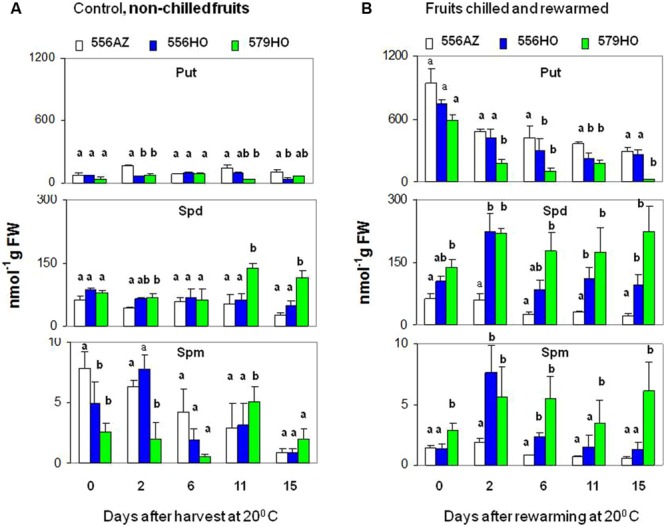
Changes in the levels of putrescine (Put), spermidine (Spd), and spermine (Spm) in (A) tomato fruits harvested at mature green stage (indicated by day 0) from the indicated lines and held at 20°C, representing controls for samples shown in (B) for which mature green fruits harvested from the indicated lines were first chilled by incubation at 2°C for 14 days (day 0) and then re-warmed at 20°C for the indicated days. Samples in triplicate were removed for each line at days 2, 6, 11, and 15, and analyzed for the content of each polyamine. Bars represent standard error of means (n = 3). Data sets were evaluated by one-way analysis of variance (ANOVA) with Tukey’s post hoc multiple comparison test to find differences among three lines for each polyamine. Single letters mark the top of each bar, those that share similar letters were found not significantly different at P < 0.05.